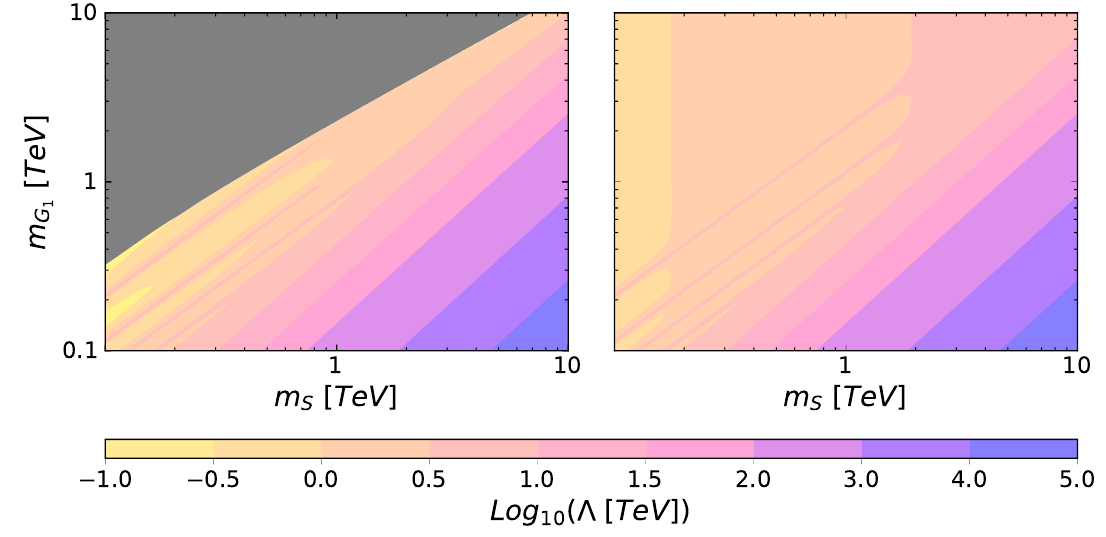
Figure 5 . Values of (cid:3) for which the correct DM relic abundance is obtained in the plane ( m Left panel: the extra-dimension length is stabilized without using the radion; Right panel: the extra-dimension length is stabilized using the Goldberger-Wise mechanism, with a radion mass m r = 100 GeV. The required (cid:3) ranges from 100 GeV to 10 5 TeV, as shown by the color legend. can be achieved by the resonant virtual radion exchange channel for DM masses around (cid:2) (cid:0) (cid:1)(cid:3) m S (cid:24) m r = 2 1 + O m 2 = (cid:3) 2 . Since the radion decay width is rather small, for r